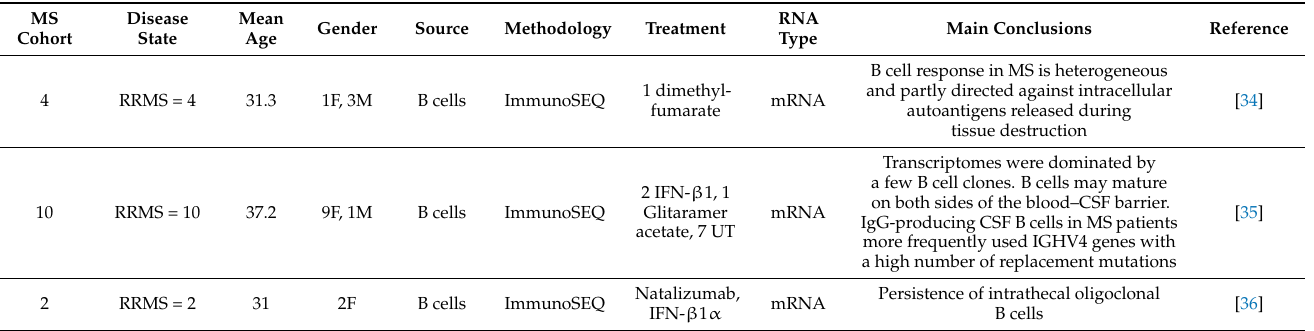
Table 2. Overview of the studies exploring transcriptomes in the human